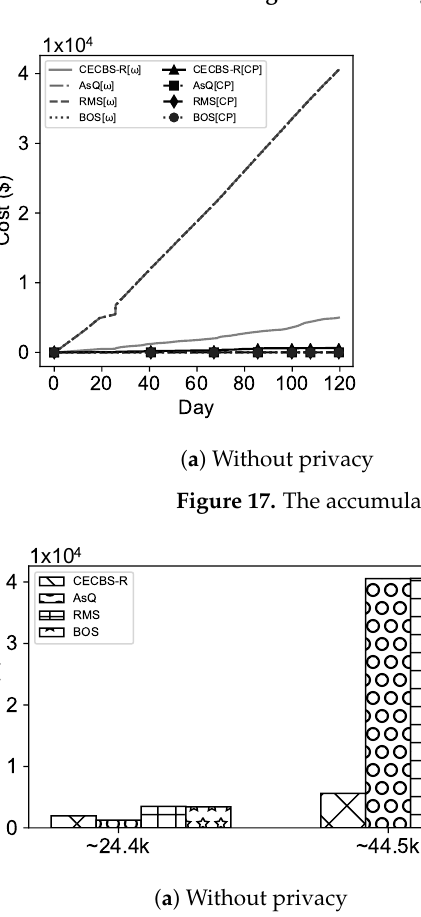
Figure 18. The total cost across the edge-cloud environment without privacy and under 10%